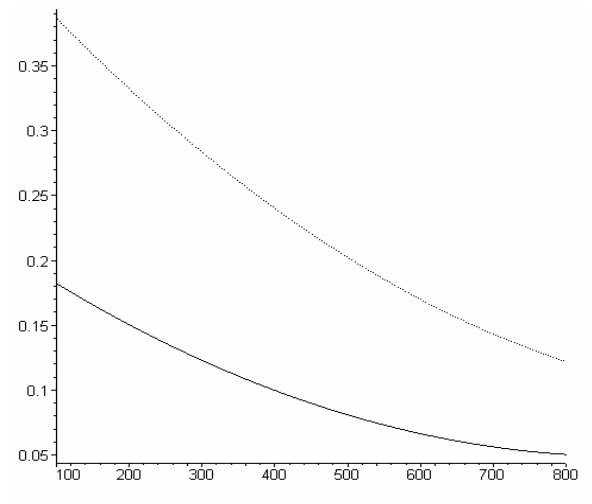
Fig 7. The dependence of the hit probability on distance. The dotted line is the probability for the attacking soldier and the solid line is for the defending soldier